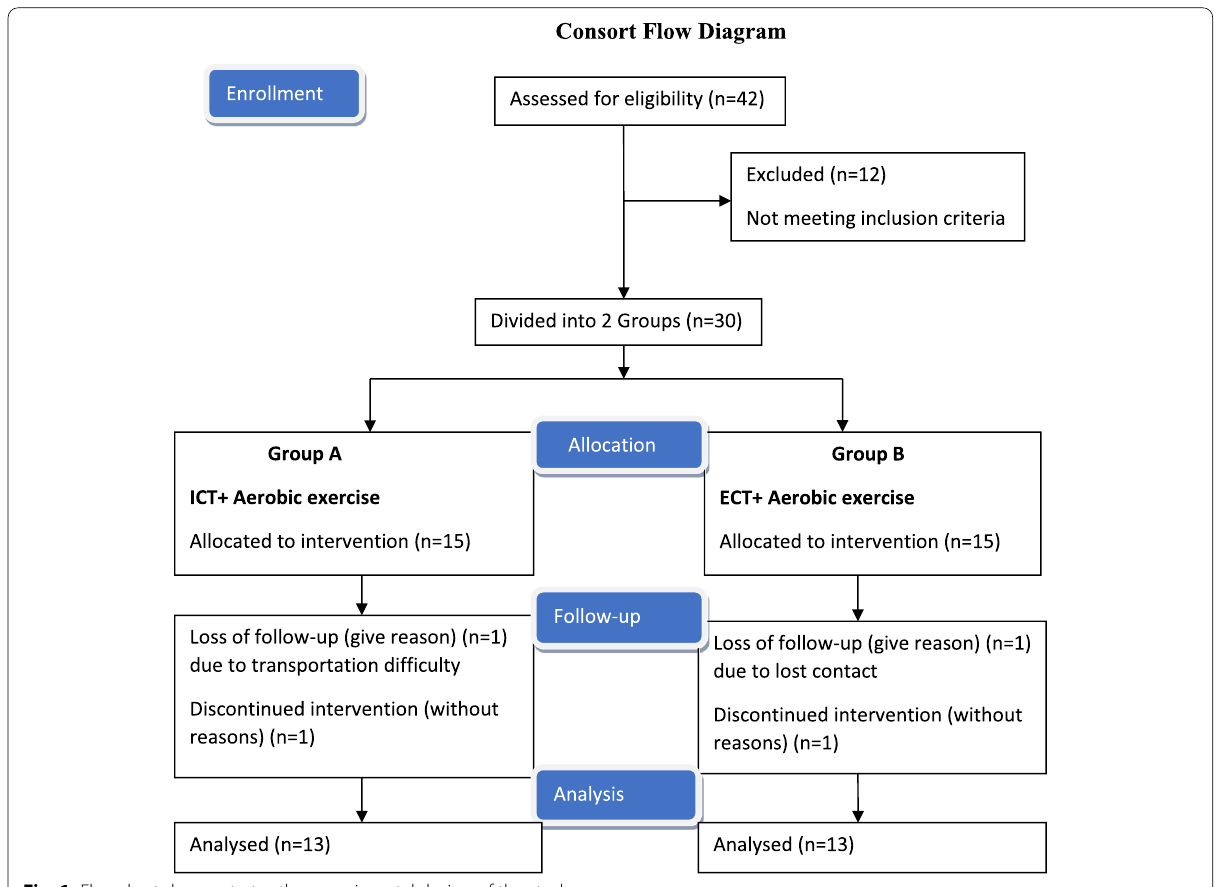
Fig. 1 Flowchart demonstrates the experimental design of the